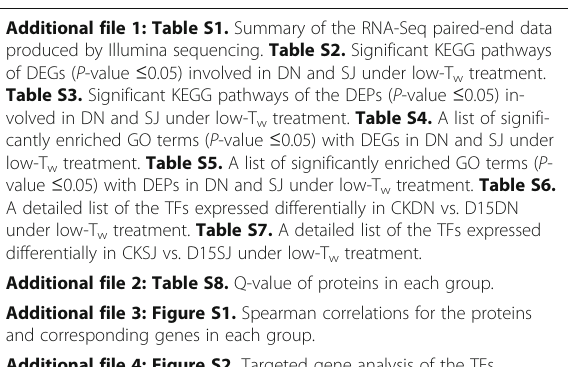
Additional file 4: Figure S2. Targeted gene analysis of the